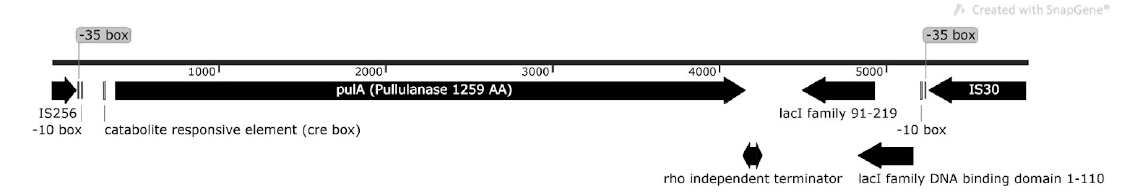
Figure 2. The pulA locus (4842 bp) in the chromosome of L. crispatus RL10.